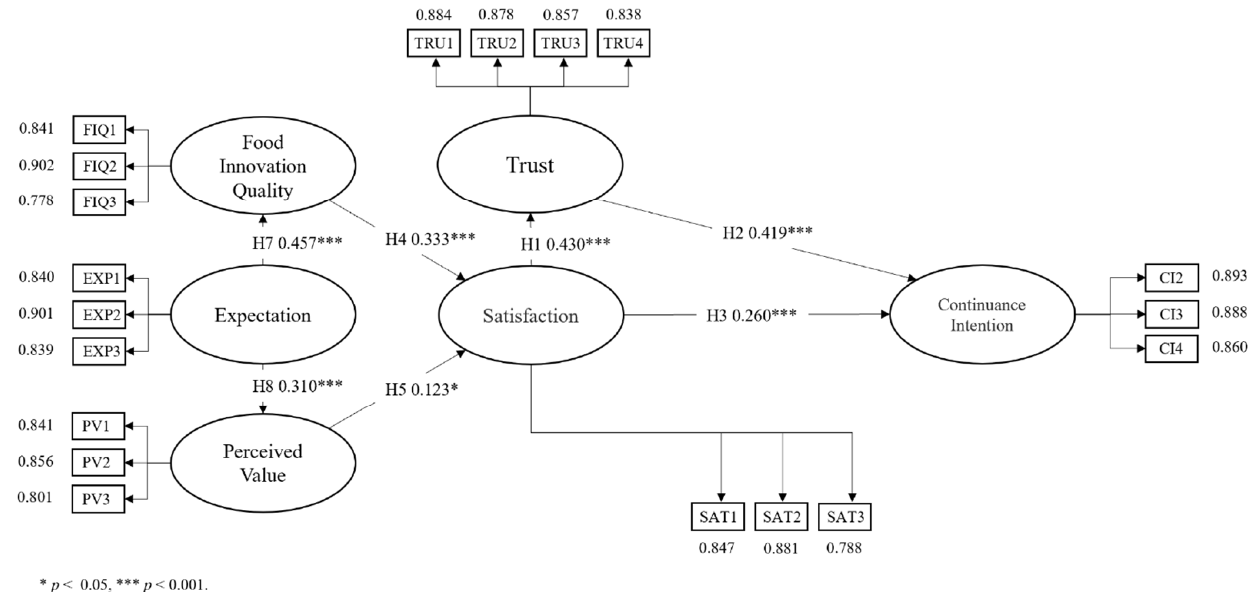
Figure 2. Research structure pattern diagram.